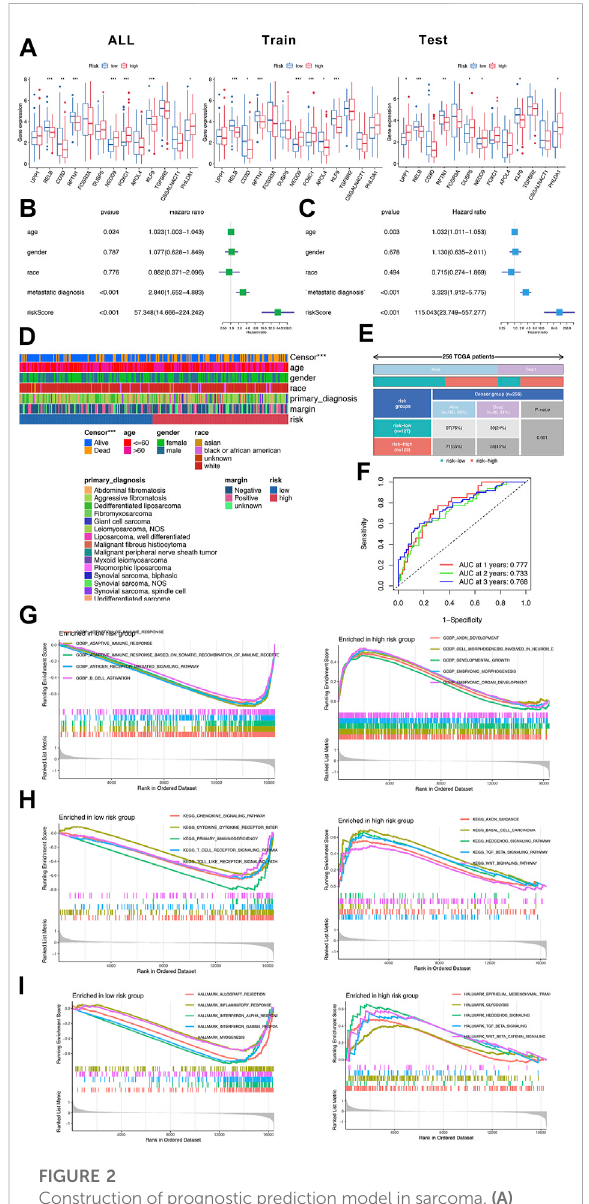
FIGURE 2 Construction of prognostic prediction model in sarcoma. (A) The differential expression of 13 DEeRNAs in the prognostic prediction model. (B) The univariate Cox regression analysis of training set. (C) The multivariate Cox regression analysis of training set. (D) The summary of clinical information of 256 sarcoma samples in TCGA database. (E) The classi fi cation of sarcoma samples based on the risk score and censor group. (F) The ROC curves of the prognostic prediction model at 1-year, 2- years and 3-years (G) The GO analysis of low-risk group and high- risk group. (H) The KEGG analysis of low-risk group and high-risk group. (I) The hallmarks of cancer identi fi ed by GSVA in low-risk group and high-risk